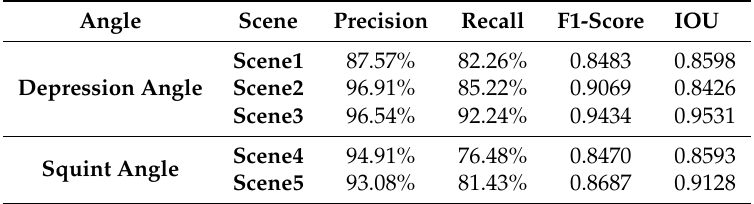
Table 1. Detection performance of the proposed